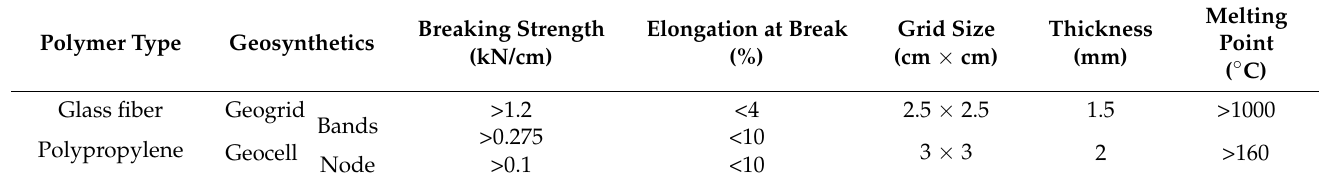
Table 3. Performance of PP geocell and GF